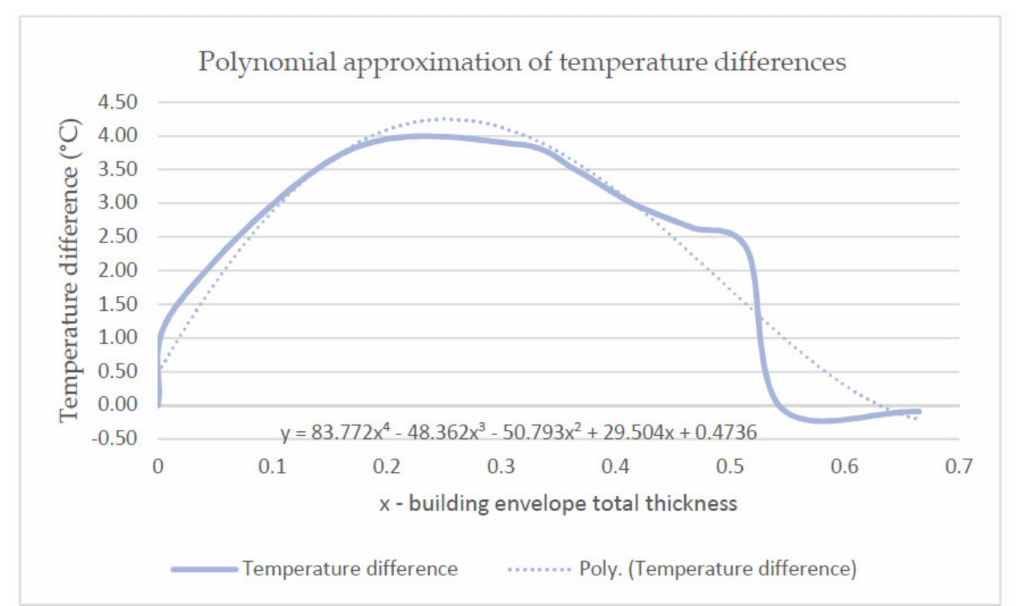
Figure 16. Polynomial approximation of temperature differences.